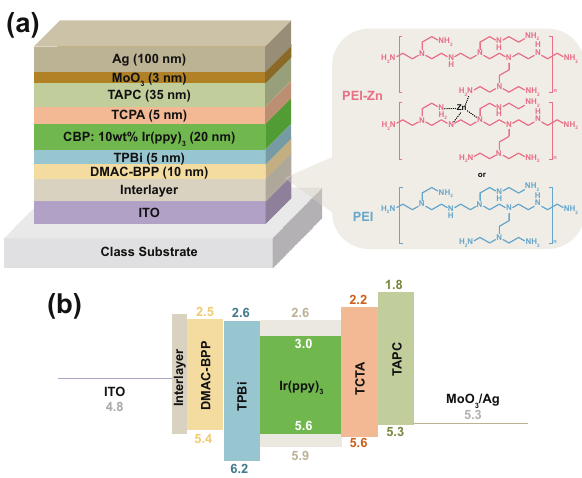
Fig. 1 a Device structure and b energy level diagram of an inverted OLED with a PEI‑Zn or a PEI